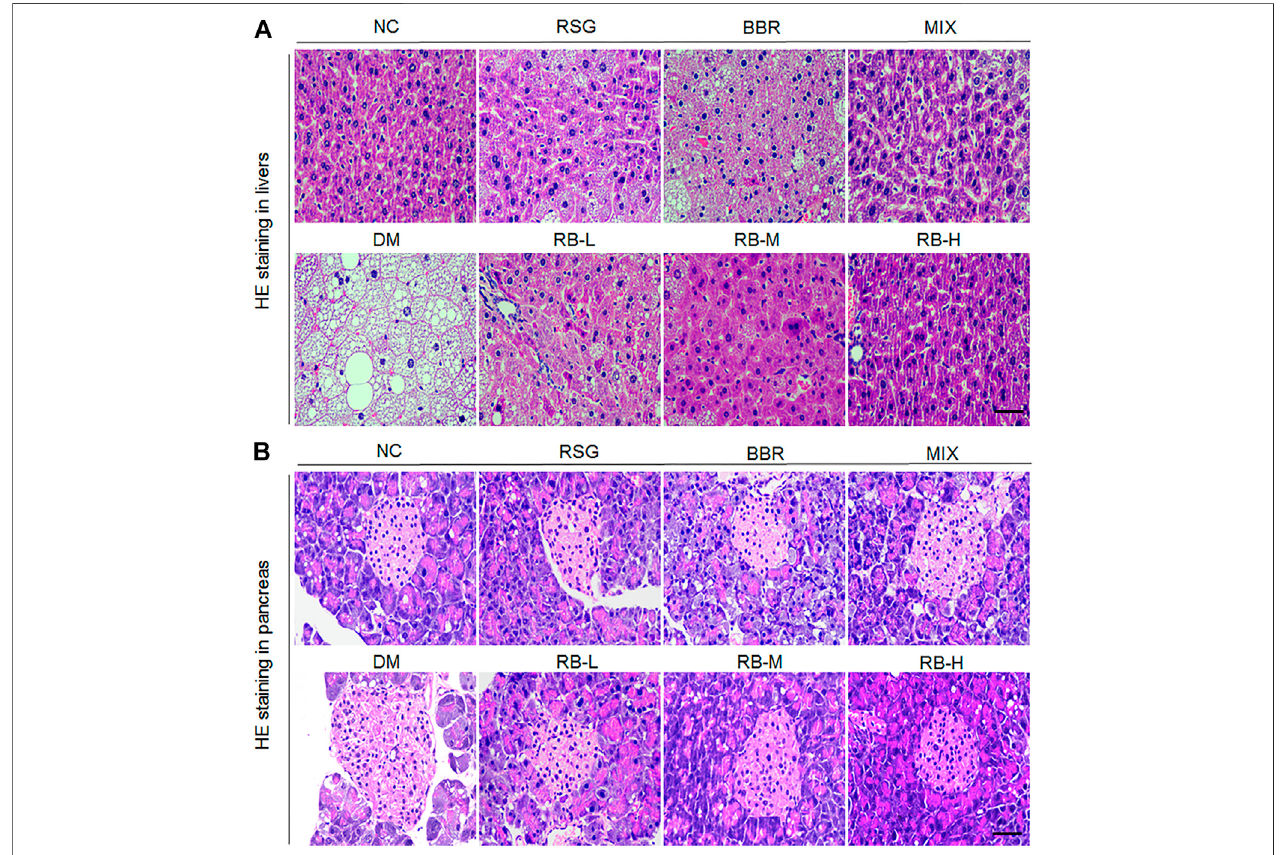
FIGURE 4 | Effects of RB on histopathological alterations in KKAy mice. (A) Hepatic histopathological alterations; (B) Pancreatic islet histopathological alterations. Scale bar, 50 μ m.